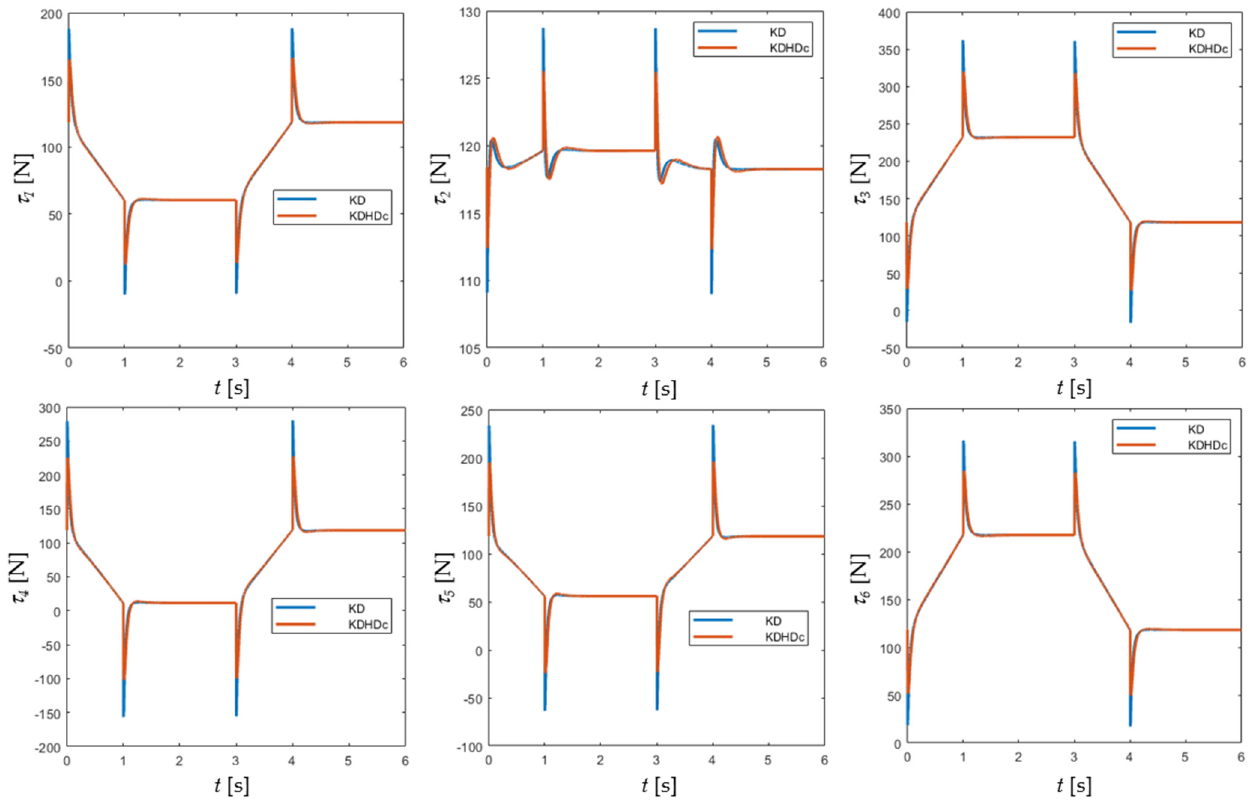
Figure 4. Case study A, KD–KDHDc comparison, actuation forces. Adopting the KDHDc impedance control, the peaks of actuation forces are lower (av- erage reduction over the six actuators: − 13%, Figure 4), and the control effort, calculated according to the following equation,